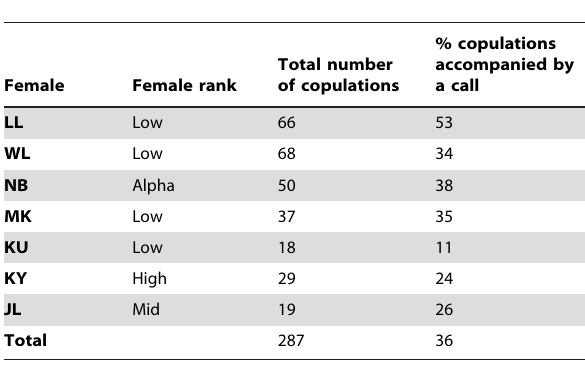
Table 1. Rank and copulation calling behaviour of seven adult females of the Sonso community, Budongo Forest, Uganda